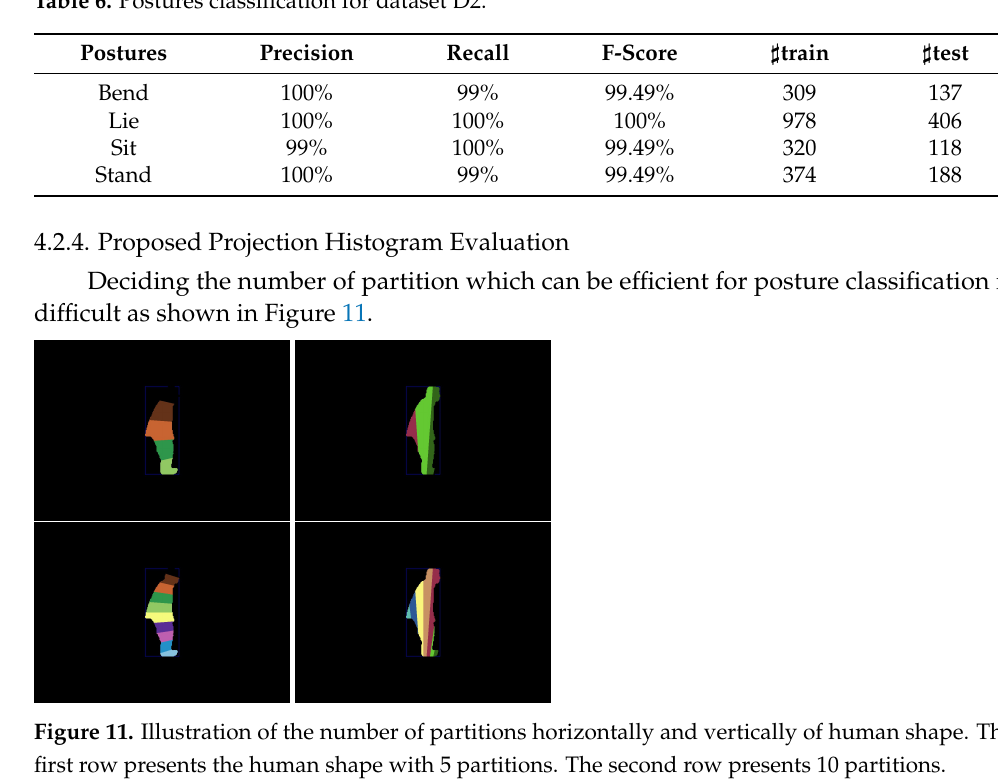
Table 6. Postures classification for dataset D2.